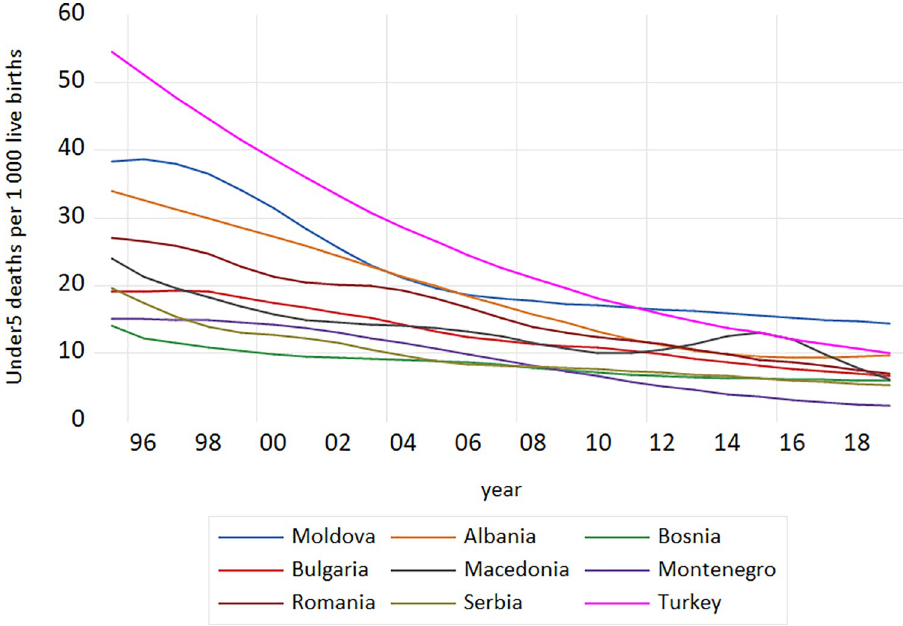
Fig 2. Under five mortality rate per 1000 live births in the European middle income countries: 1995–2019. Source: Author’s design based on World Bank and UN data.